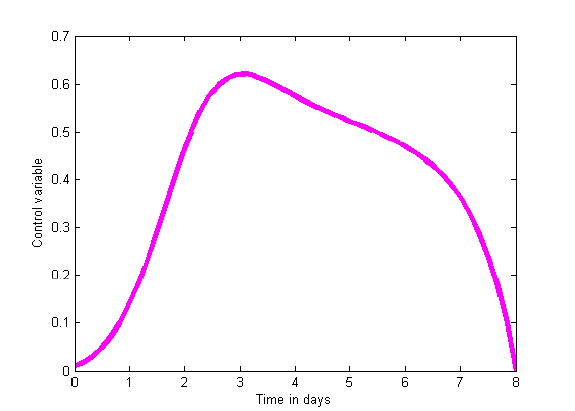
Fig. 5. Control variable verses time (in